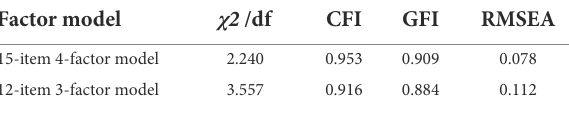
TABLE 3 Fit statistics for the 12-item 3-factor and 15-item 4-factor model. Factor model